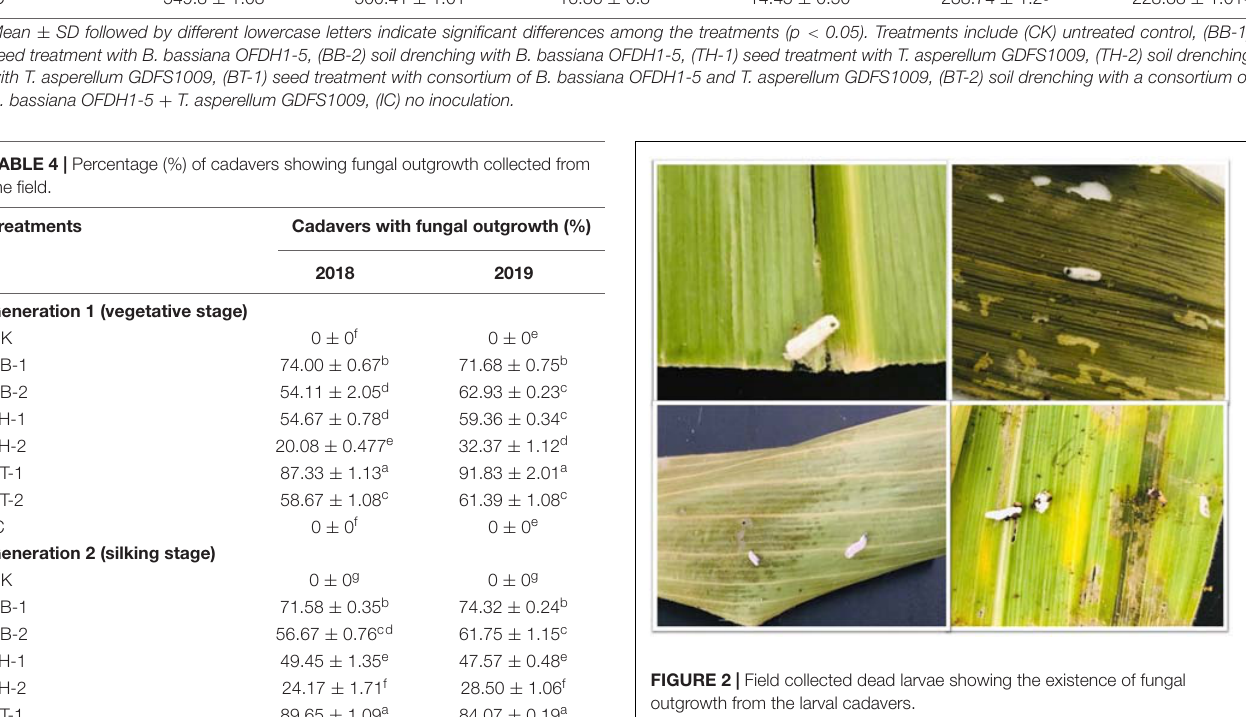
at 24-h of insect feeding and gradually decreased until 48- h, while polyphenol oxidase (PPO) reached the maximum at 48-h. The production of antioxidant enzymes was further triggered by entomopathogenic fungal treatments and the highest productions were observed in consortium treatment